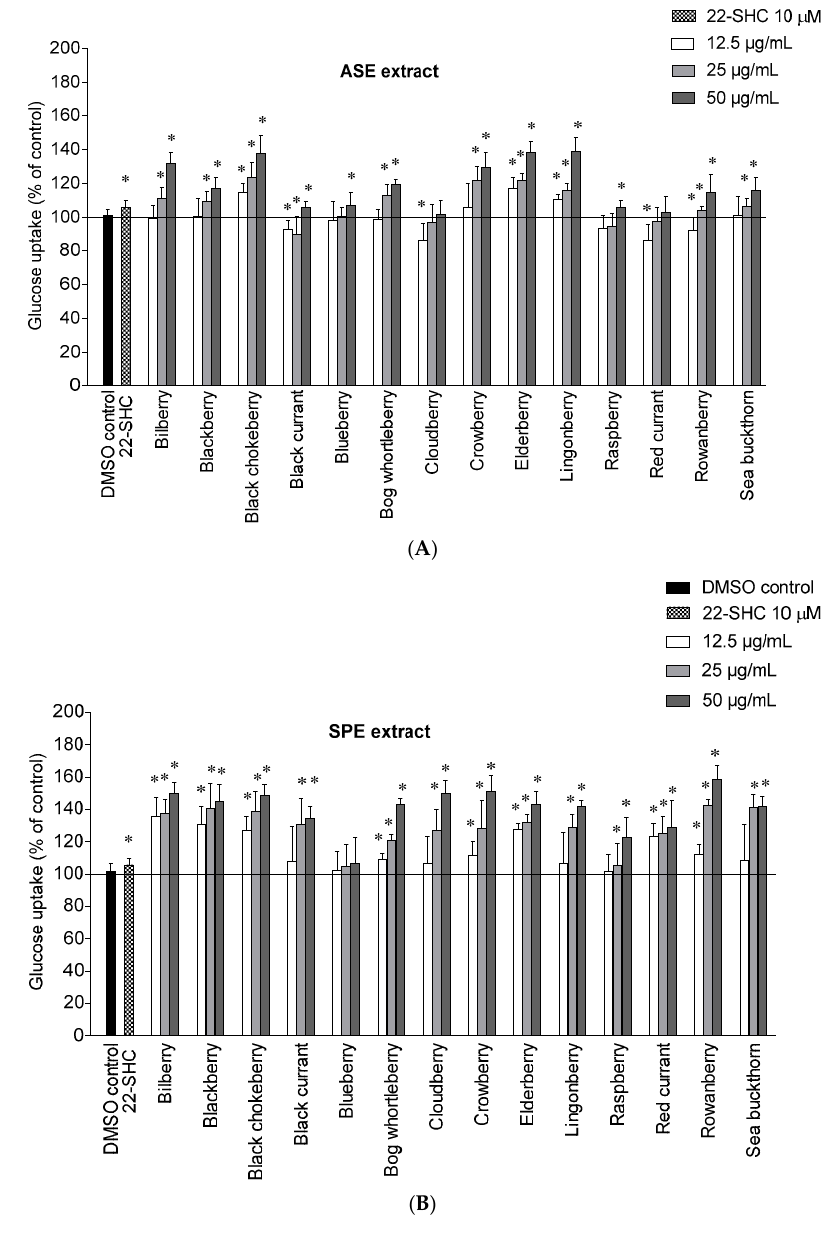
Figure 1. Effects of berry extracts on glucose uptake in human liver cells. HepG2-cells were treated with ( A ) 12.5, 25 and 50 µg/mL of different berry ASE extracts and ( B ) 12.5, 25 and 50 µg/mL of different berry SPE extracts for 24 h. Thereafter, the cells were exposed to D -[ 14 C(U)]glucose (1 µCi/mL, 100 µM) for 4 h as described in Materials and Methods. 22- S -hydroxycholesterol (22-SHC) (10 µM) was used as positive control. The figures show D -[ 14 C(U)]glucose uptake given as means ± SEM ( n = 3) from separate experiments. * p < 0.05 vs. control (0.1% DMSO).